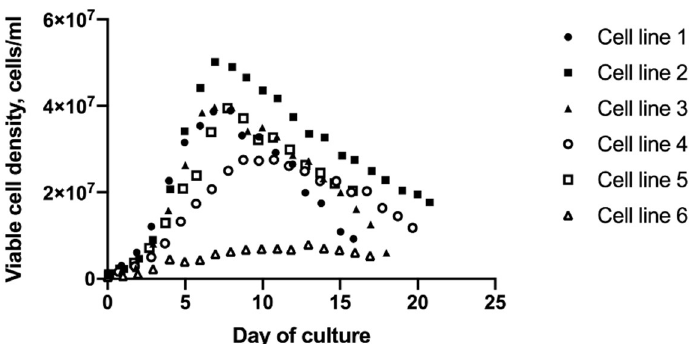
Figure 1. Daily measurements of viable cell density. Cell lines from host 1 (CHO K1 GS knockout) and host 2 (DG44) are indicated by closed and open symbols, respectively. Each cell line produces a different mAb. All six cell lines were grown using the same basal and feed media under identical reactor operating conditions.